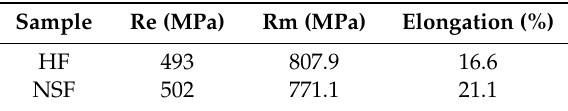
Table 10. Average mechanical properties of hot ‐ forged (HF) and NSF components after the same heat treatment.